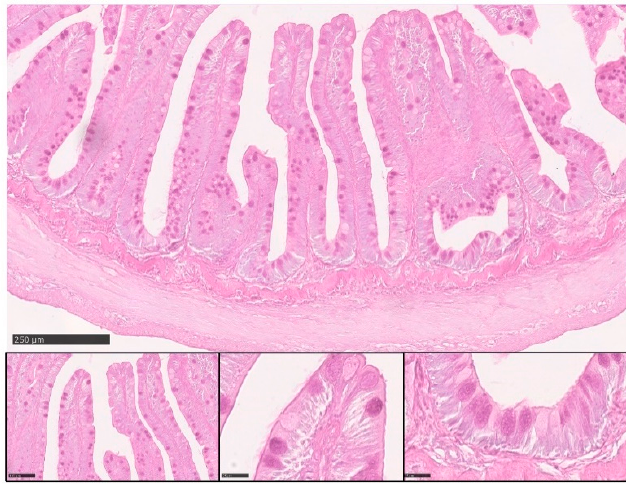
Figure 8. Representative figure of PAS stained section of the anterior intestine of rainbow trout.